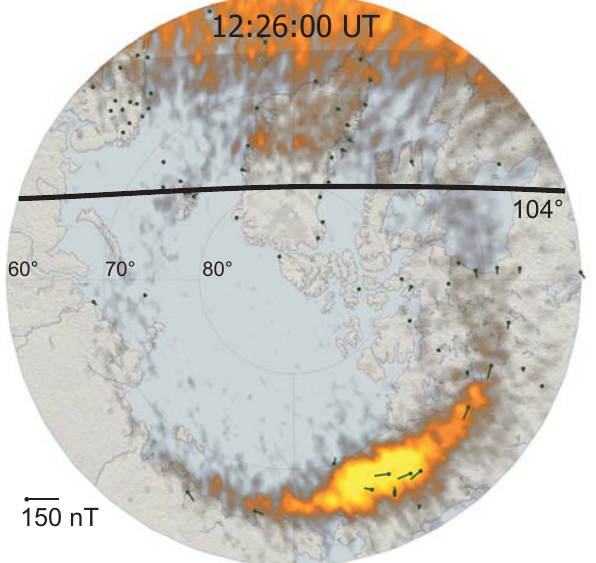
Fig. 11. Auroral activity at 12:26:00UT on 25 December 2000. Ground magnetic field vectors (units of nT) rotated 90 ◦ clockwise to indicate the equivalent current direction superposed onto an im- age obtained at 12:26:17UT by the Polar Visible Imaging System’s Earth camera (courtesy L. A. Frank and J. B. Sigwarth). The camera provided global auroral images in the far ultraviolet (FUV) range of ∼ 124–149nm. Notice that the ionospheric currents are clearly associated with the auroral emissions thereby indicating that these currents are due to processes internal to the